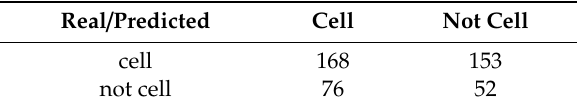
Table 4. Confusion matrix for extraction